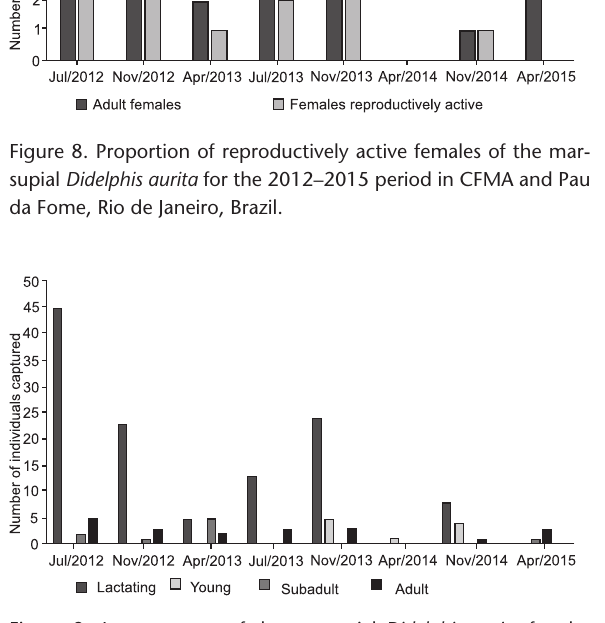
Figure 9. Age structure of the marsupial Didelphis aurita for the 2012–2015 period in CFMA and Pau da Fome, Rio de